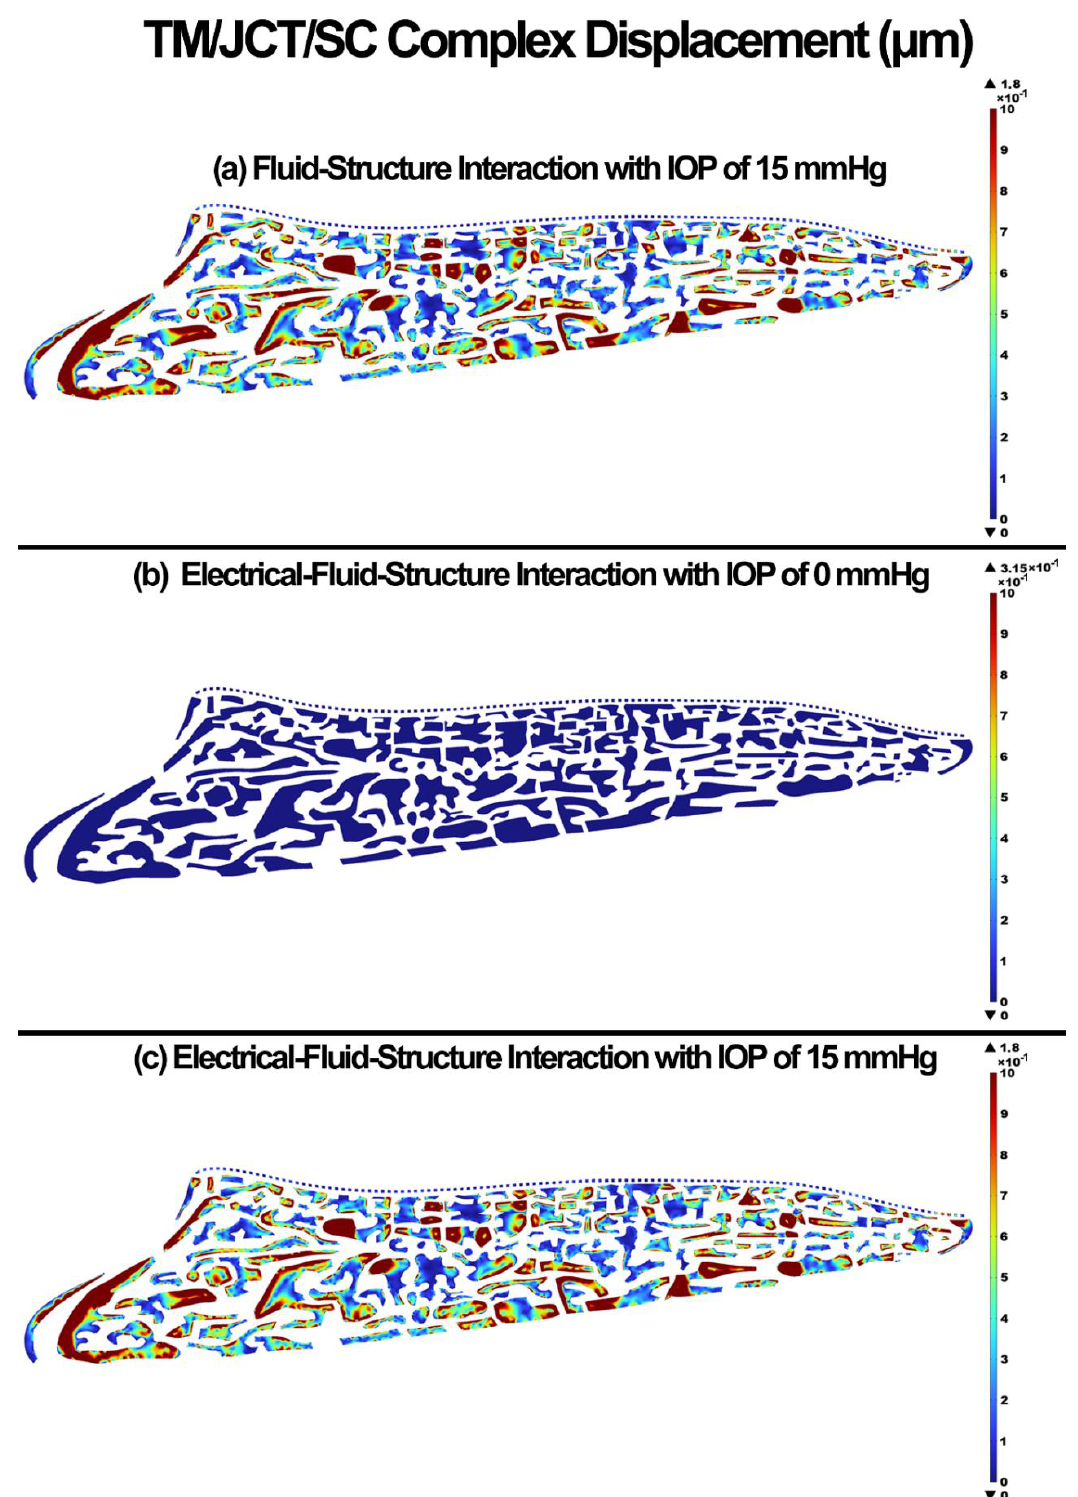
Figure 8. The displacement in the TM/JCT/SC complex. ( a ) FSI model with IOP of 15 mmHg, ( b ) EFSI with IOP of 0 mmHg, and ( c ) EFSI with IOP of 15 mmHg.